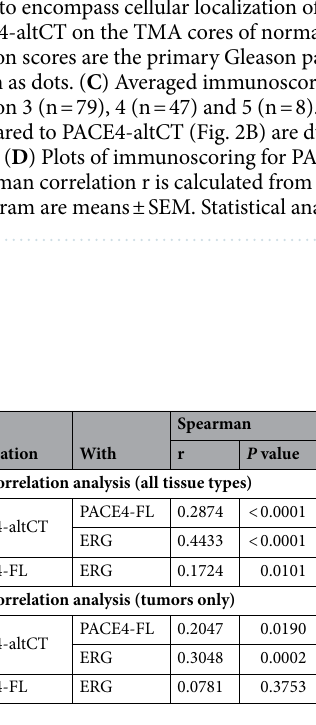
Table 1. Correlation analysis between tissues